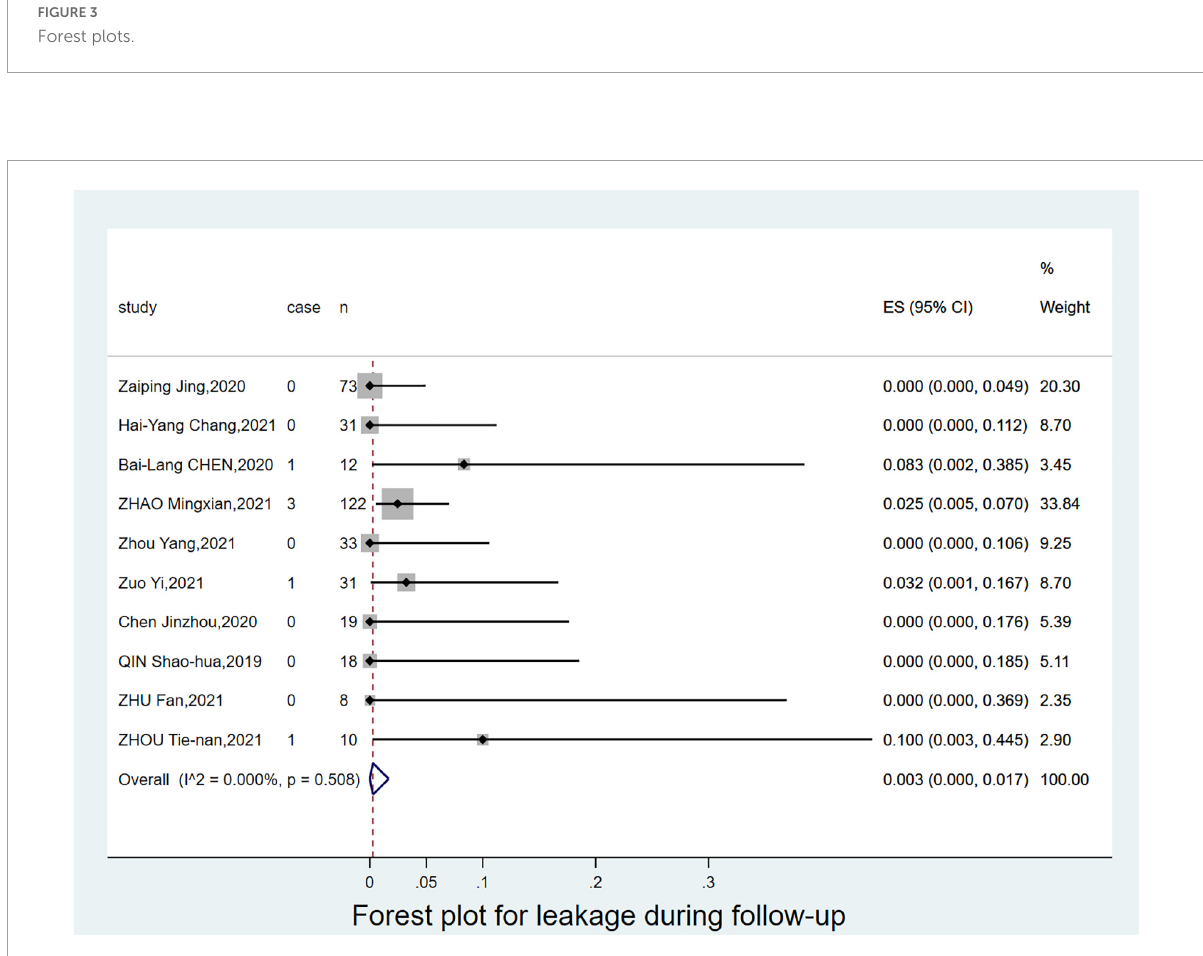
FIGURE4 Forest plot for leakage during